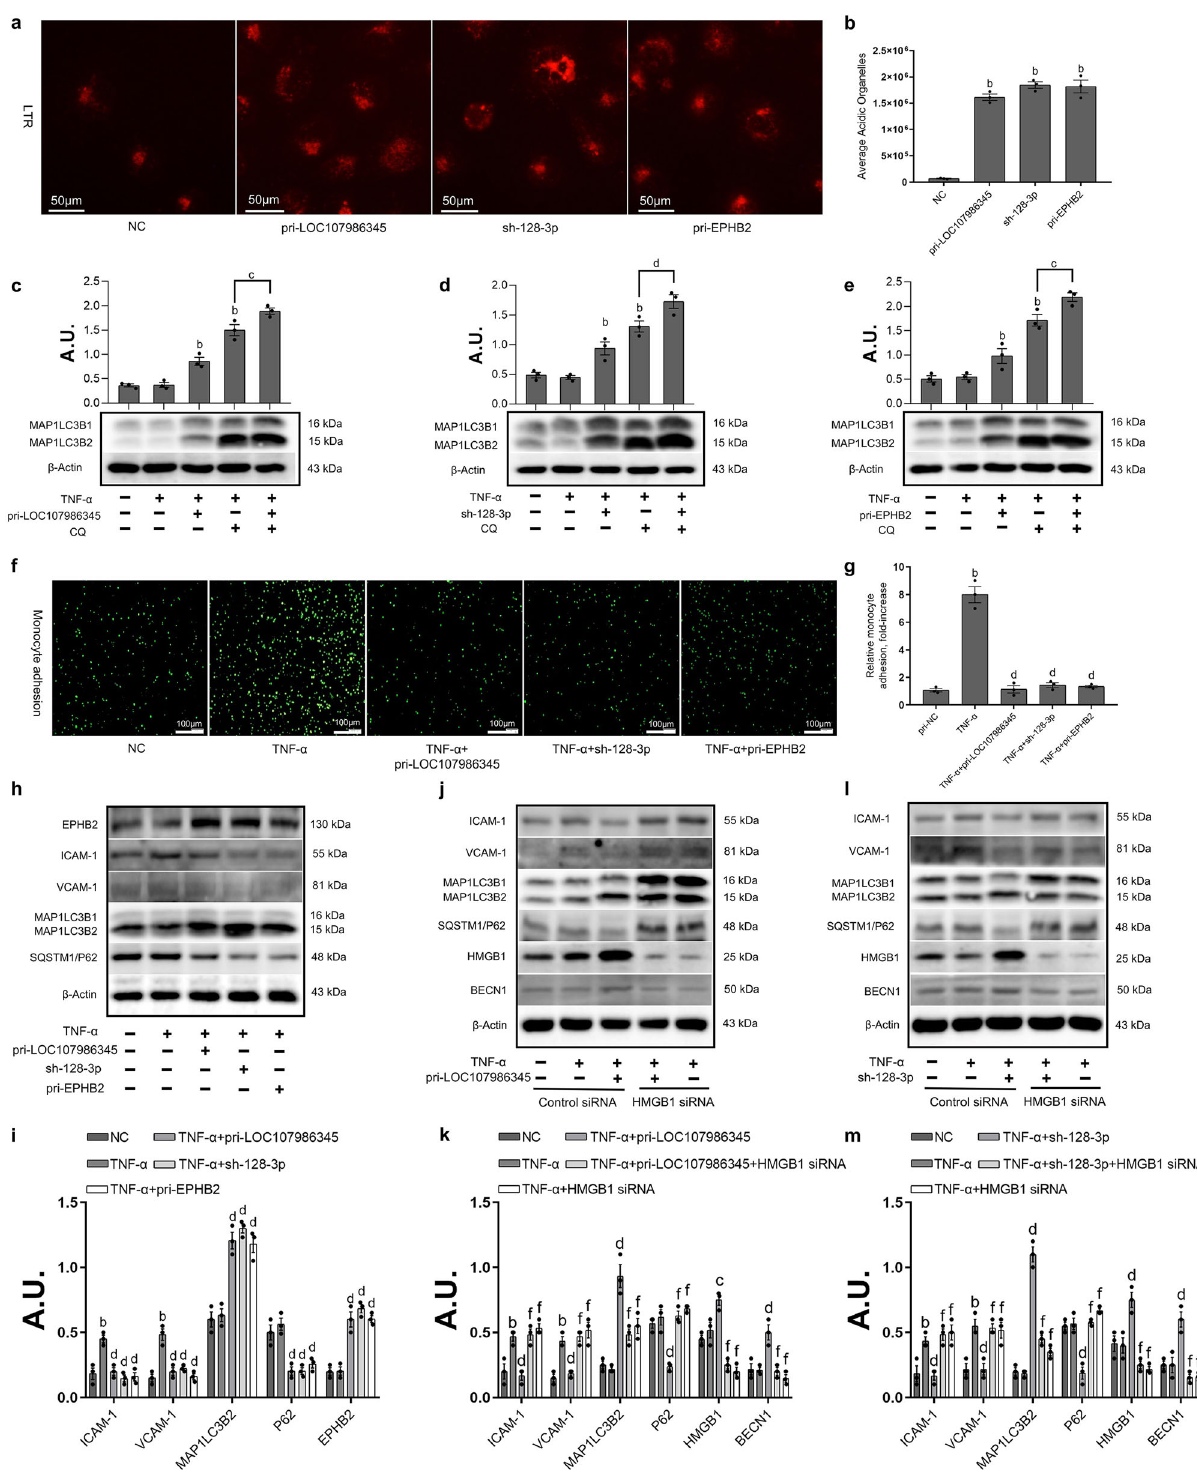
Fig. 6 The inhibition of endothelial in fl ammatory by LSS depends on autophagy activation resulting from the nuclear translocation of HMGB1 via LOC107986345/miR-128-3p/EPHB2 axis. a , b Confocal microscopy shows the effect of pri-LOC107986345, sh-miR-128-3p and pri-EPHB2 activated autophagy (HAECs stained with Lyso Tracker Red). c – e Western Blot shows the expression of MAP1LC3B2. f , g Confocal microscopy shows the effect of pri-LOC107986345, sh-miR-128-3p and pri-EPHB2 inhibited monocyte adhesion. h , i Western Blot shows the anti-in fl ammatory effect of pri- LOC107986345, sh-miR-128-3p and pri-EPHB2. j , k Western Blot shows the effect of HMGB1 siRNA on anti-in fl ammatory effect of pri-LOC107986345. l , m Western Blot shows the effect of HMGB1 siRNA on anti-in fl ammatory effect of sh-miR-128-3p. Data are presented as mean ± SEM of three independent experiments. a P < 0.05, b P < 0.01 vs. NC group; c P < 0.05, d P < 0.01 vs. TNF- α or TNF- α + CQ group. e P < 0.05, f P < 0.01 vs. TNF- α + pri- LOC107986345 or sh-miR-128-3p group. AU, arbitrary units.